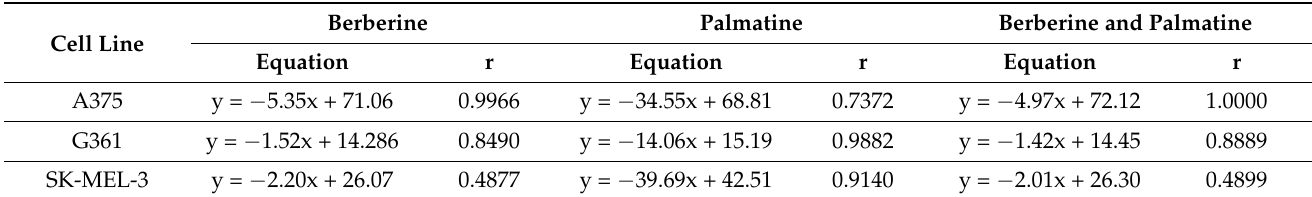
Table 4. Equation of correlation curve and correlation coefficients (r), values between isoquinoline alkaloid contents and cytotoxic activity expressed as IC 50 of investigated plant